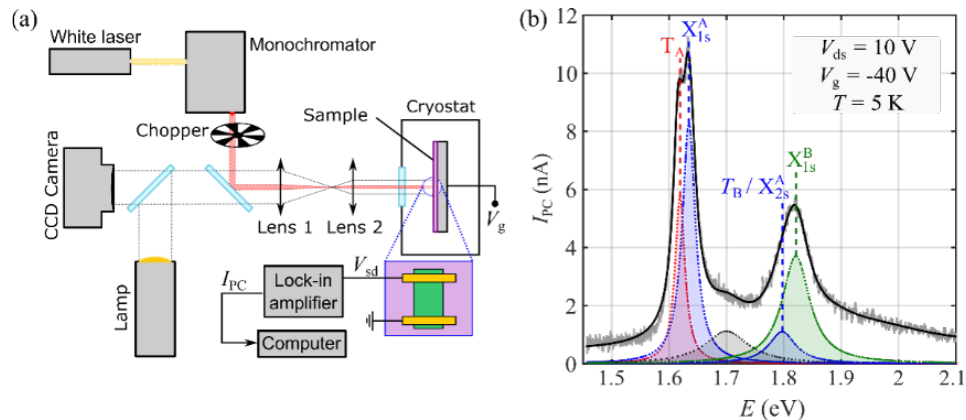
Figure 3. Photocurrent spectroscopy measurements: ( a ) Schematic of the low-temperature photocurrent setup. ( b ) Photocurrent spectrum of the MoSe phototransistor (grey line) and fitting to a multipeak Lorentzian function (black). The spectral features identified are depicted below the photocurrent spectrum.